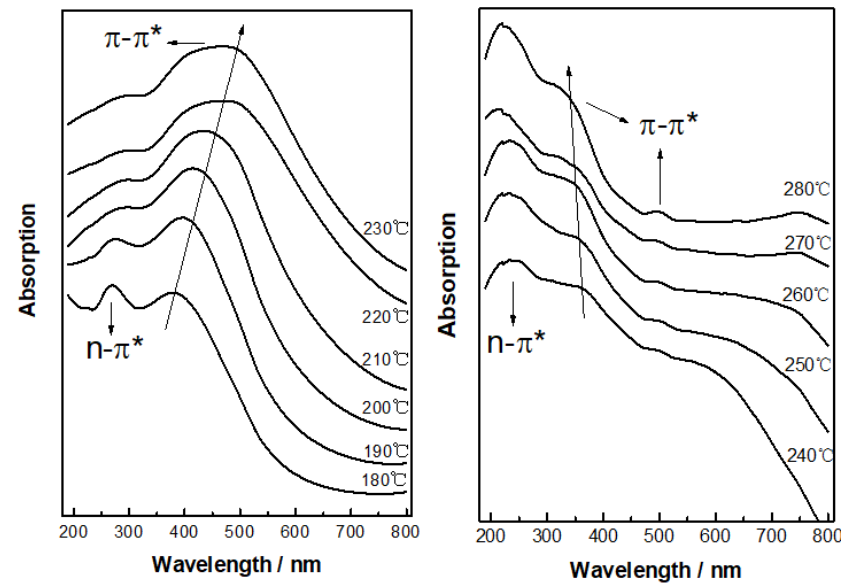
Figure 4. UV-vis spectra of PAN fibers treated at different thermal stabilization temperatures.